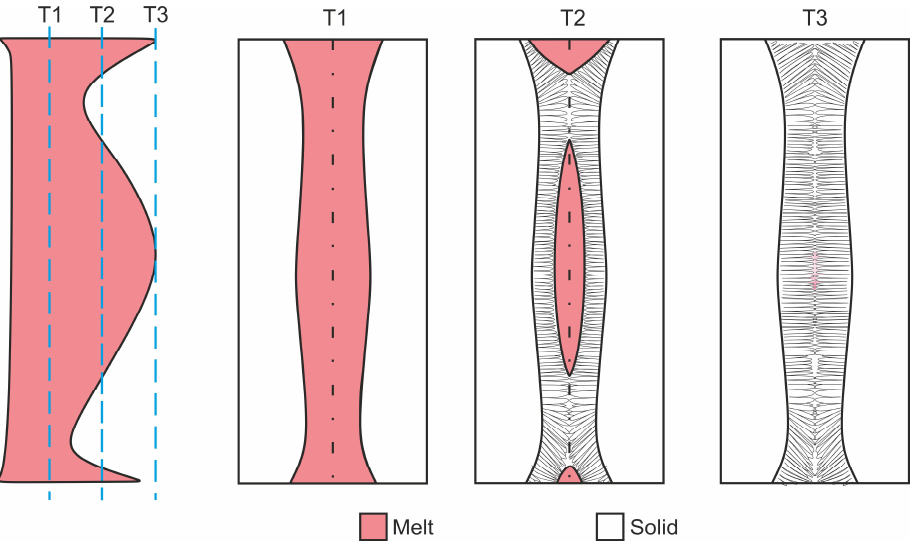
Figure 17. Schematic illustration of the distribution of the melt and solid in three points in time (T1, T2 and T3) during solidification of the weld pool.